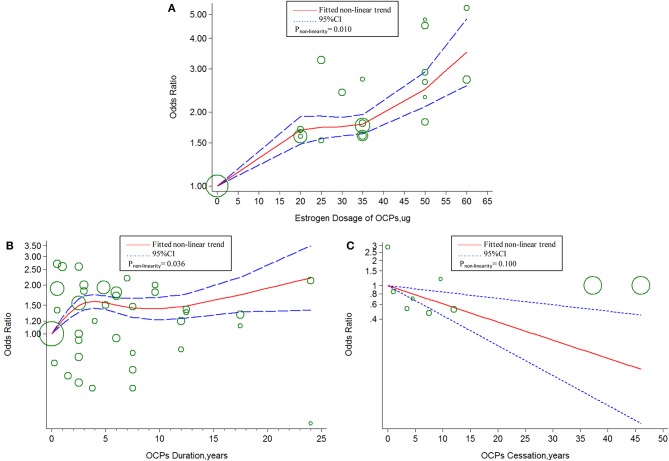
Dose–response relationship between OCPs [(A) estrogen dosage of OCPs, (B) OCPs duration, (C) OCPs cessation] and risk of ischemic stroke. The circles represent the ORs in each individual study with the circular size reflecting the weight of corresponding study. OCP, oral contraceptives.